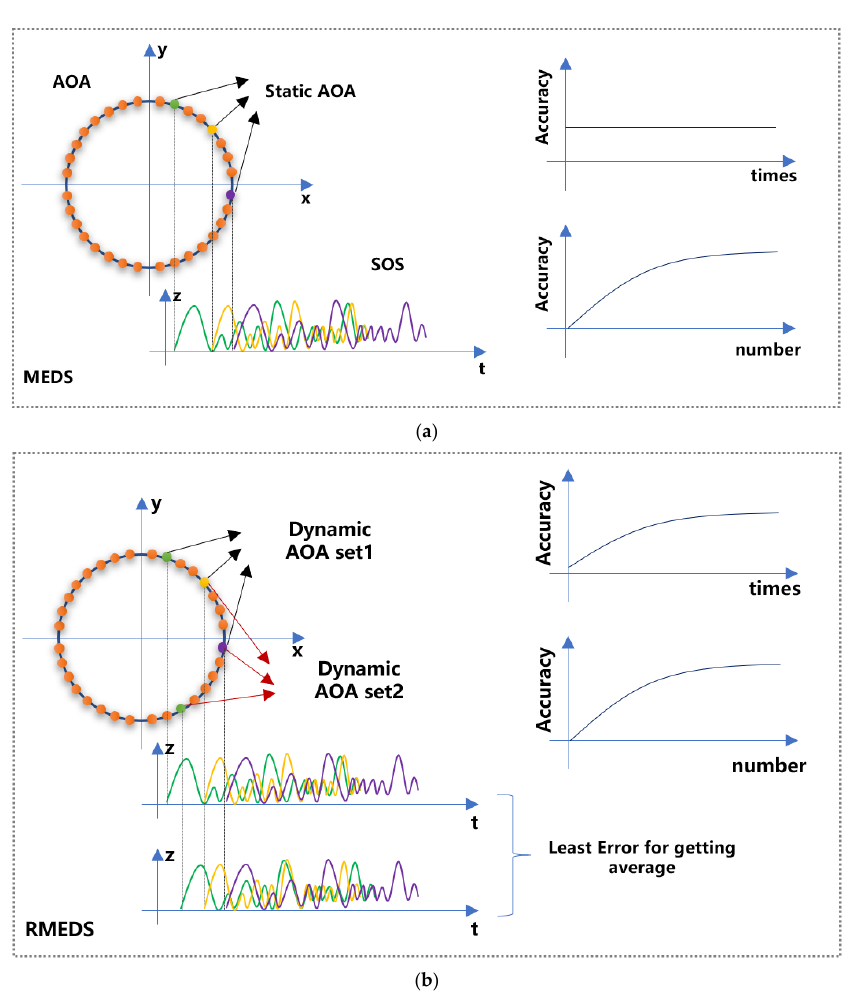
Figure 4. ( a ) The models and performances of MEDS . ( b ) The models and performances of RMEDS. To reduce the complexity of simulations and implementation, MEDS-SP [27] was proposed, with part sinusoids into K sets according to AOA and the average of each set to improve the performances. The model of MEDS-SP is shown in Figure 5.